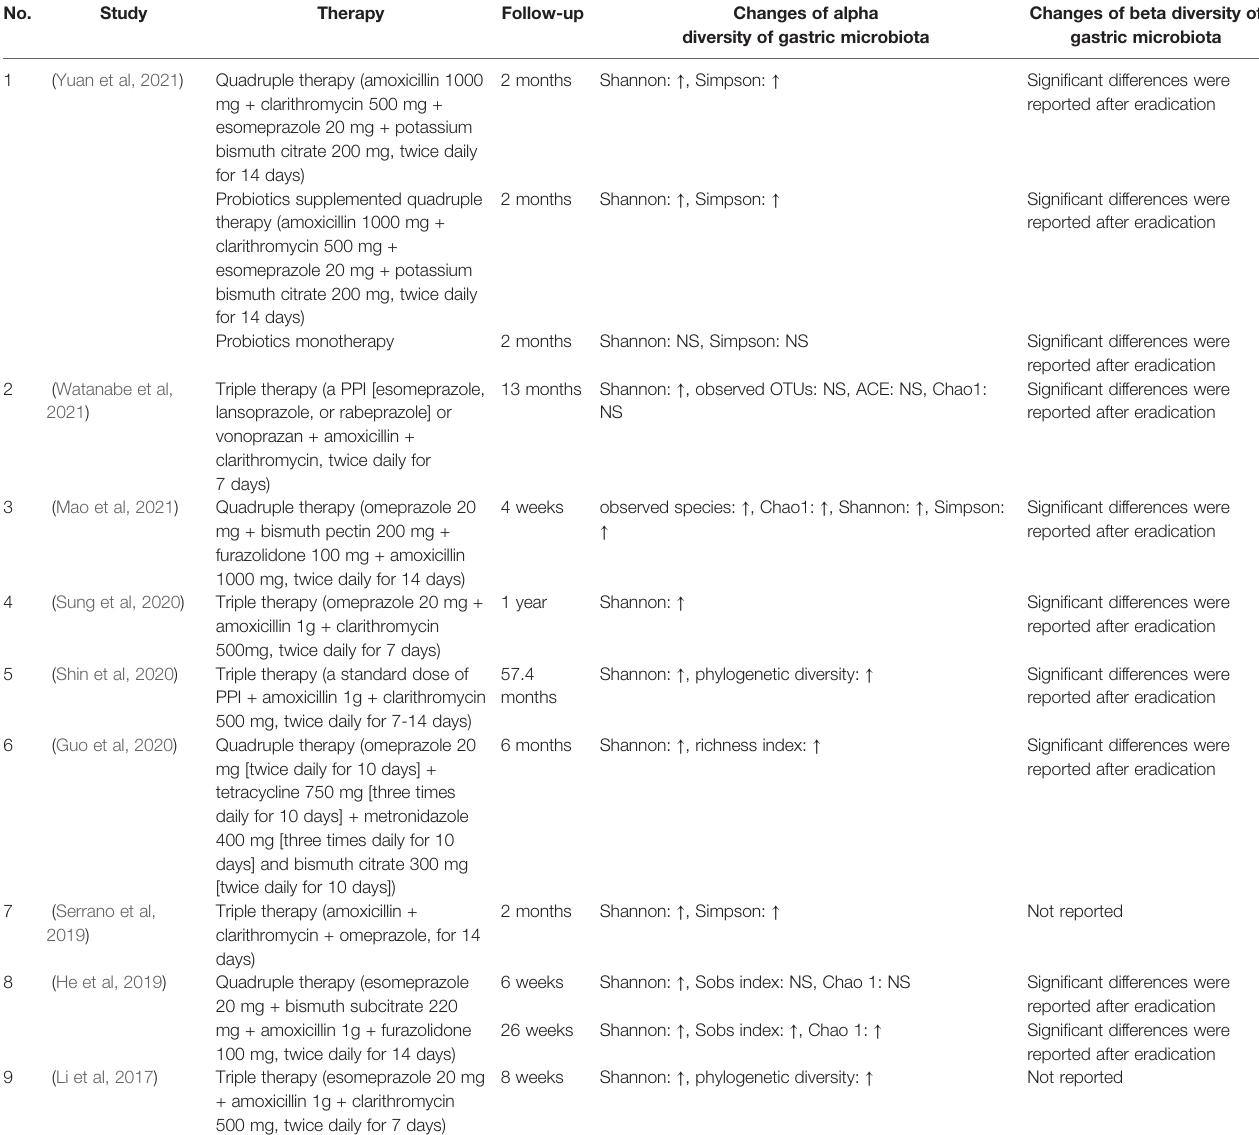
TABLE 2 | Major fi ndings of the included studies on alpha and beta diversity of gastric microbiota. No. Study